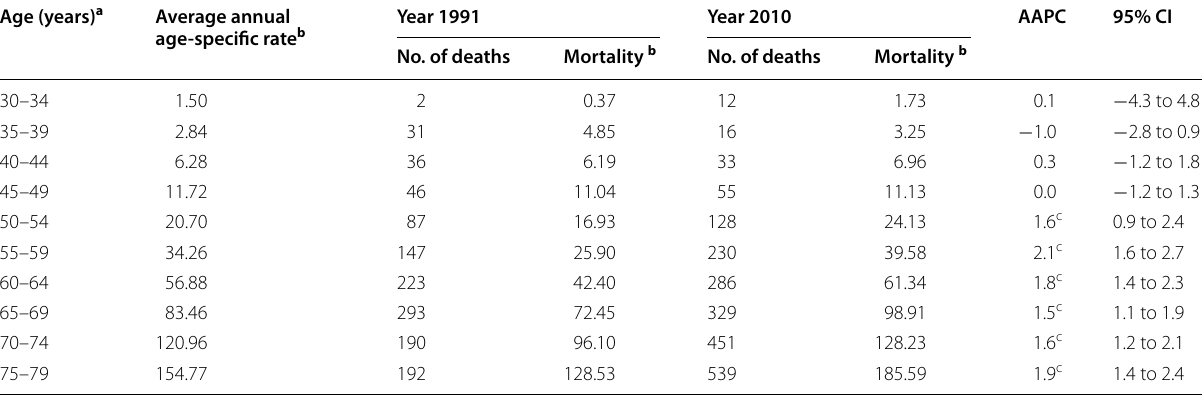
Table 2 Joinpoint regression analysis of colorectal cancer mortality in Serbia (by age) during the period 1991–2010, with data for the beginning and the end of the study period